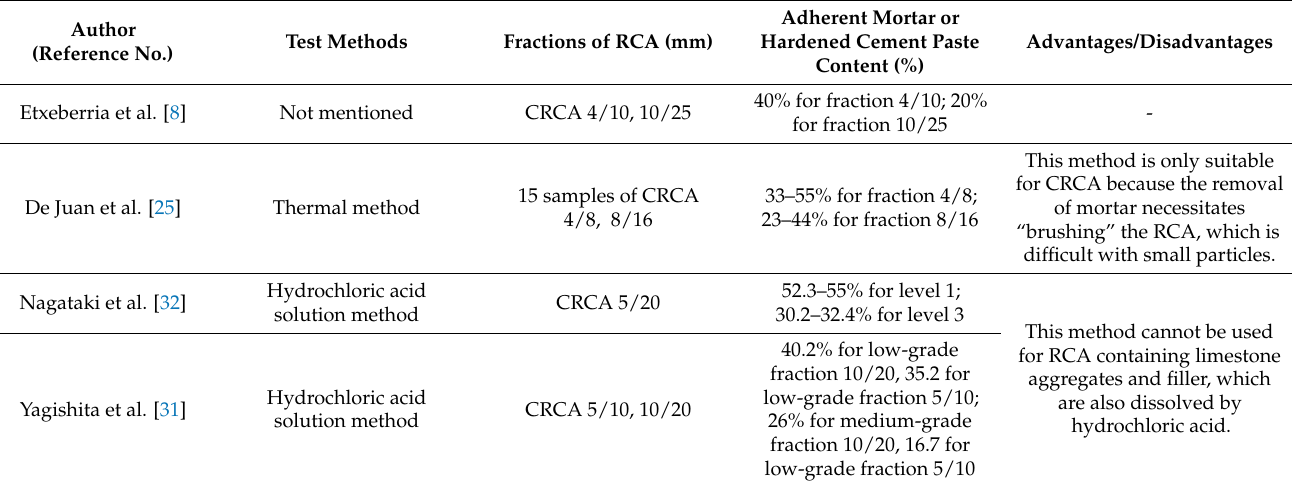
Table 1. Summary of the hardened cement paste content or adherent mortar content measurement of RCA from